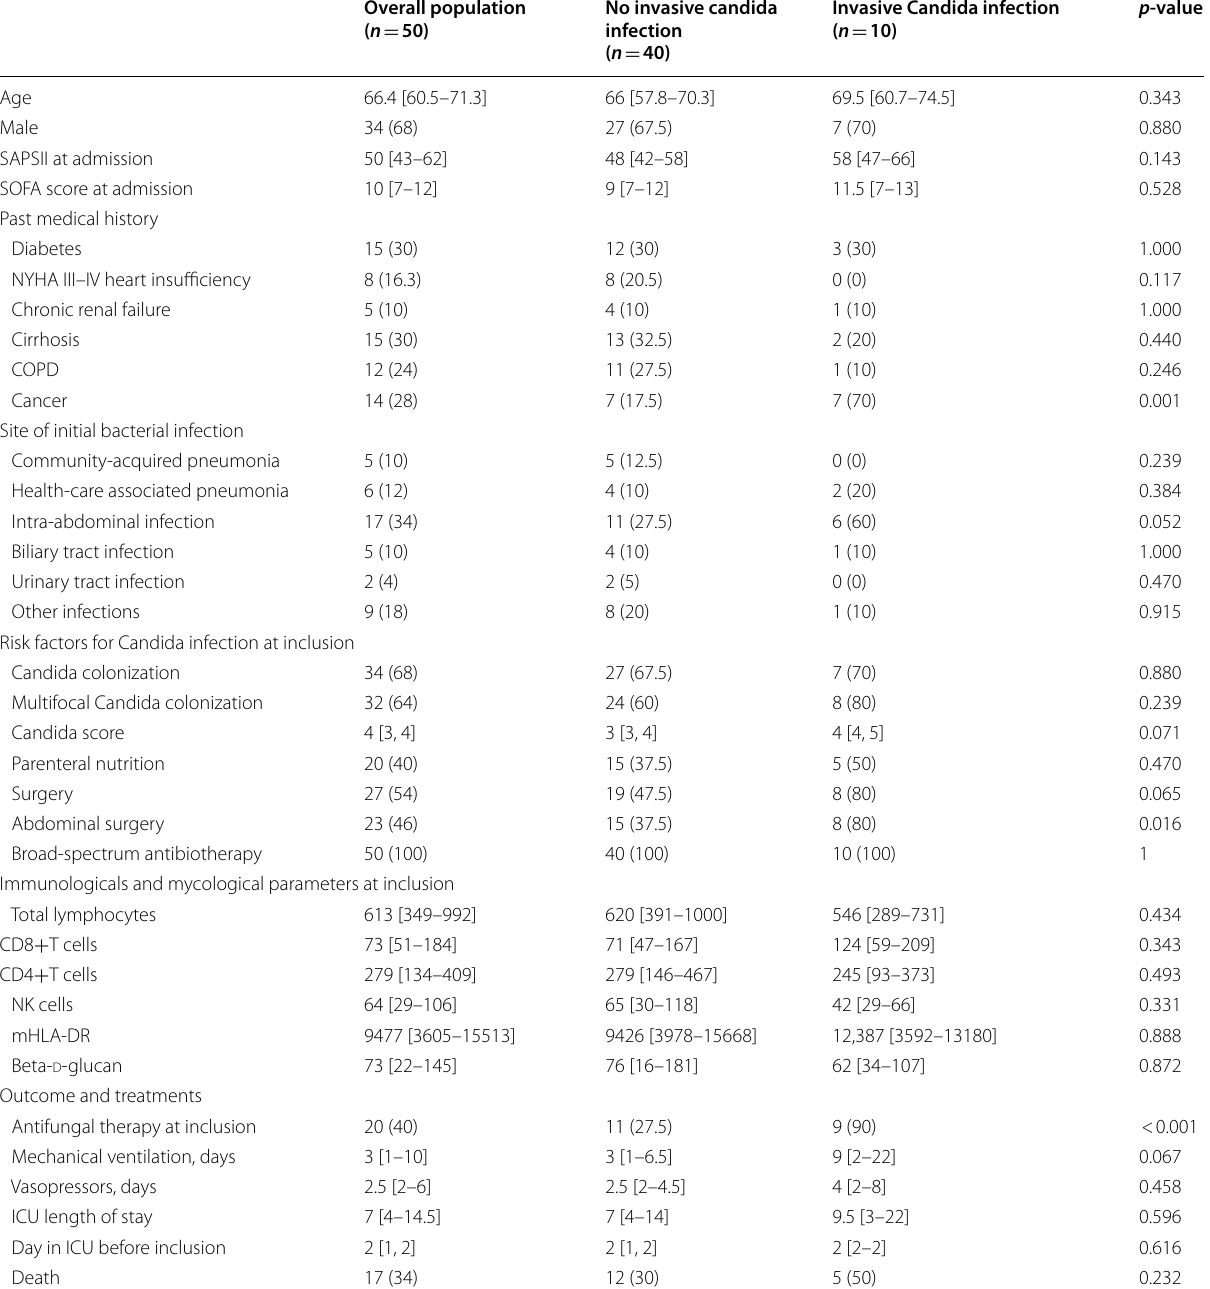
Table 1 Characteristics and outcome of the study